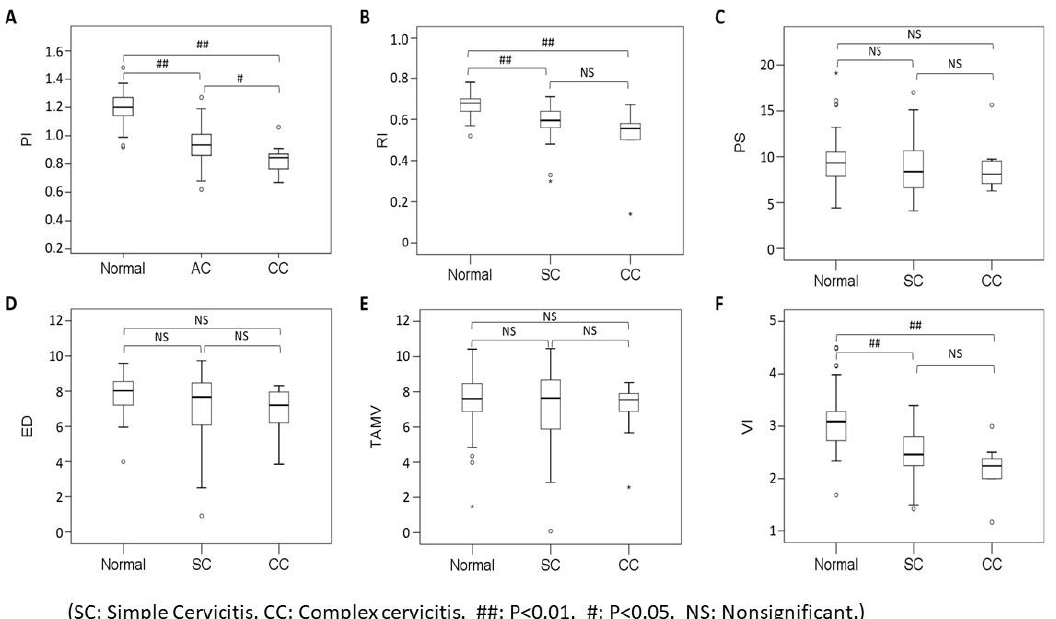
Figure 6. Box plot showing the correlation between 6 sonographic parameters of cervix (PI, RI, PS, ED, TAMV, VI) among the simple cervicitis group (SC) ( n = 26), complex cervicitis group (CC) ( n = 12) and control group ( n = 41). ( A ) Disease severity is negatively correlated with PI. ( B , F ) RI and VI are lower in the cervicitis groups. ( C , D , E ) Patients with cervicitis and the control groups have similar distributions of PS, ED and TAMV. * Extreme outlier, o Outlier. A PI cutoff value of 1.1 had a sensitivity of 85.4%, specificity of 92.1%, positive predictive value (PPV) of 91.5%, negative predictive value (NPV) of 86.3%, and accuracy of 93.2% for acute simple cervicitis. A RI cutoff value of 0.6 had a sensitivity of 85.4%, specificity of 78.9%, PPV of 80.2%, NPV of 84.4%, and accuracy of 86.1% for acute simple cervicitis. A VI cutoff value of 2.6 had a sensitivity of 85.4%, specificity of 78.9%, and accuracy of 84.9% for acute simple cervicitis (Figure 7A, Table 3). B. ROC curve of six sonographic parameters between the group 2 ( n = 12) and group 1 ( n = 26).